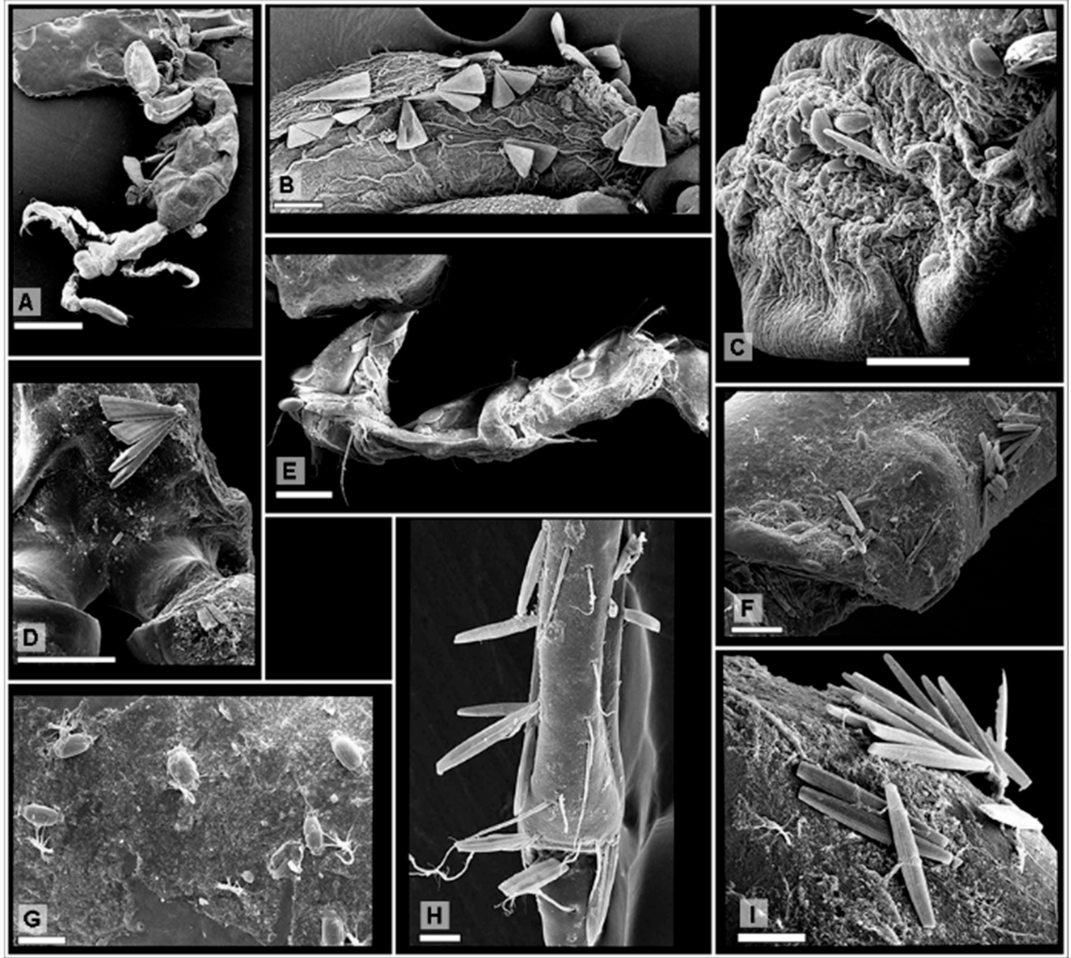
Figure 1. Diatom distributions on amphipod body parts. ( A ) Female specimen of Caprella equilibra (scale: 500 µ m); ( B ) Licmophora abbreviata on the dactyl of gnathopod 2 of C . equilibra (scale: 50 µ m); ( C ) The diatoms Amphora and Tabularia on a gill of Paracaprella pusilla (scale: 50 µ m); ( D ) Licmophora ehrenbergii on the head of P. pusilla (scale: 100 µ m); ( E ) Amphora helenensis on the pereopod 5 of P. pusilla (scale: 50 µ m); ( F ) The diatoms Halamphora and Tabularia on pereonite 5 of P. pusilla (scale: 50 µ m); ( G ) Halamphora coffaeiformis on pereonite 4 of P. pusilla (scale: 20 µ m); ( H ) Tabularia fasciculata on pereopod 5 of C. equilibra (scale: 20 µ m); ( I ) Tabularia affinis on the head of P. pusilla (scale: 20 µ